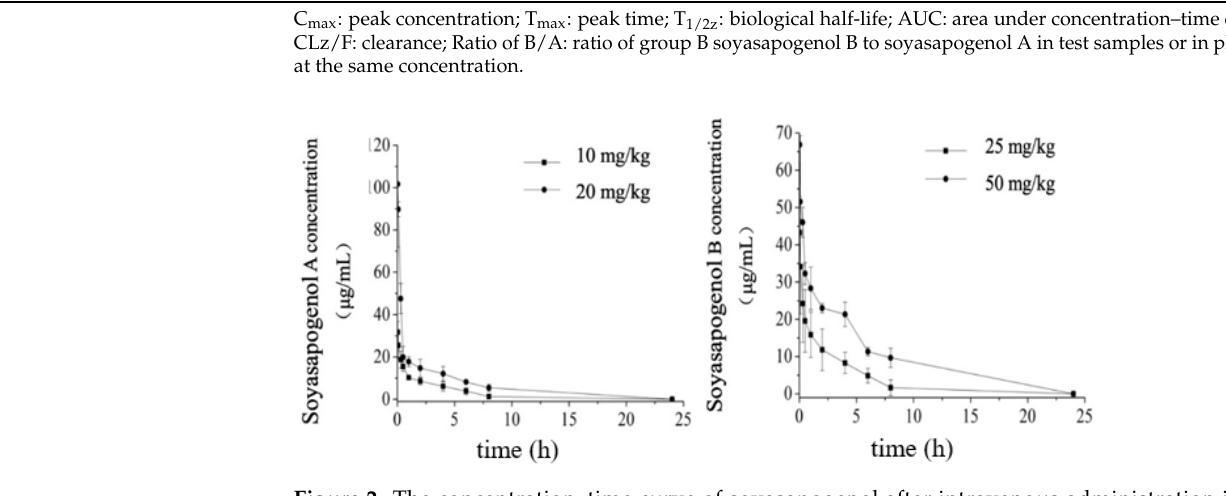
Figure 2. The concentration–time curve of soyasapogenol after intravenous administration in rat plasma ( n = 6).